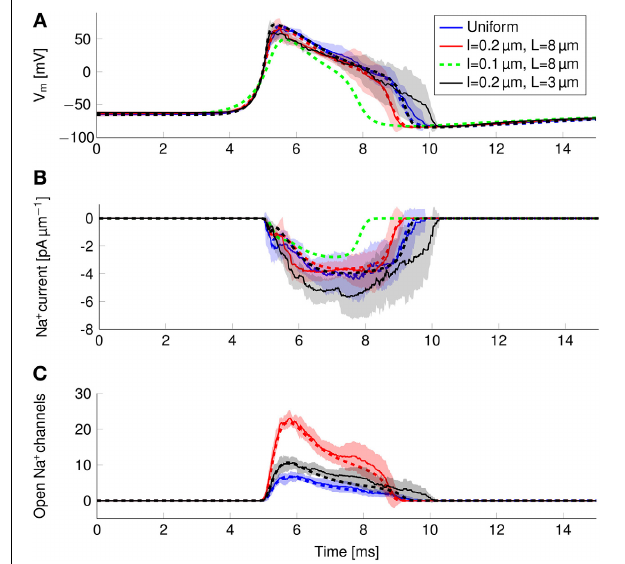
FIGURE 8 | Action potential and sodium current waveform in uniform channel density axons (Blue, STD shaded light blue, deterministic results in blue dotted line), in 0.2 µ m long clusters placed 3 µ m apart (Black, STD shaded gray, deterministic results in black dotted line), in 0.2 µ m long clusters placed 8 µ m apart (Red, STD shaded light res, deterministic results in red dotted line) and in 0.1 µ m long clusters placed 8 µ m apart (Dotted green line) in a 0.1 µ m diameter C-fiber axon. (A) The action potential waveforms (B) Instantaneous Na + current and (C) open Na + channels in a single compartment. Although there are few Na + channels open in the repolarizing phase of the AP, the larger difference between V m and E Na + creates a Na + current comparable to that of the earlier